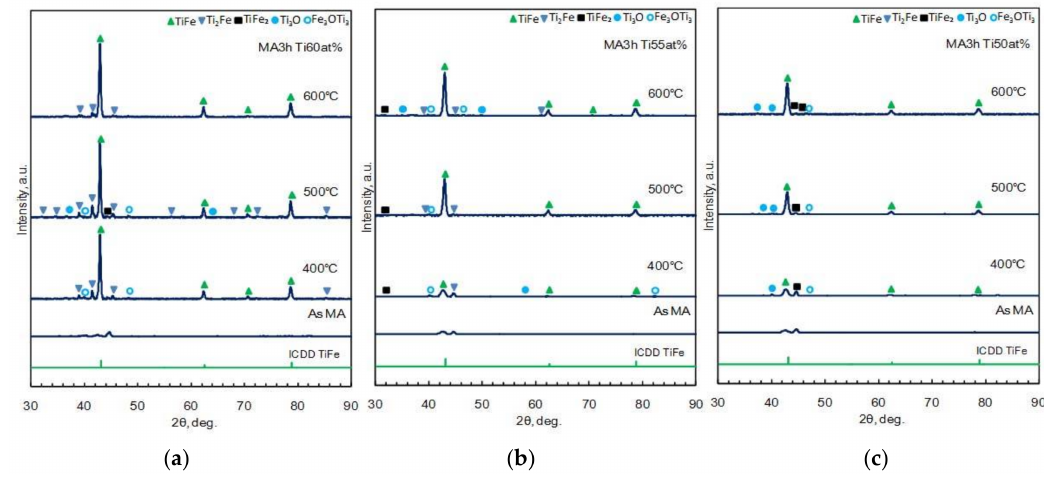
Figure 4. XRD patterns of 3 h MA samples with different Ti-contents after heat treatment at several temperatures. ( a ) 60 at % Ti-Fe; ( b ) 55 at % Ti-Fe; ( c ) 50 at %